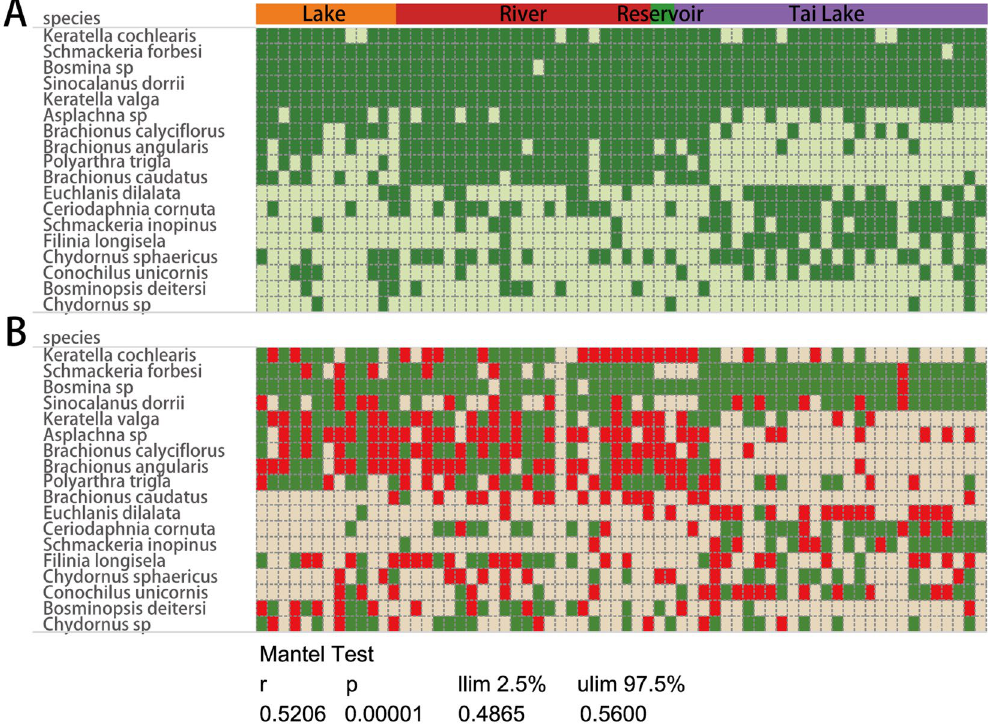
Figure 3. Comparison of the distribution characteristics of common species between metabarcoding and morphological data. Common species means the frequency of occurrence > 10 samples. ( A ) Metabarcoding data. Green dot indicates the species were detected by metabarcoding. ( B ) Morphology monitoring data. Green dot indicates the species appeared in both quantitative and qualitative sample and red dot indicates the species only appeared in the qualitative sample. (R = 0.52, p = 0.0001, mantel test, 9999 permutations). “llim” means empirical upper confidence limits of r value. “ulim” means empirical lower confidence limits of r value.